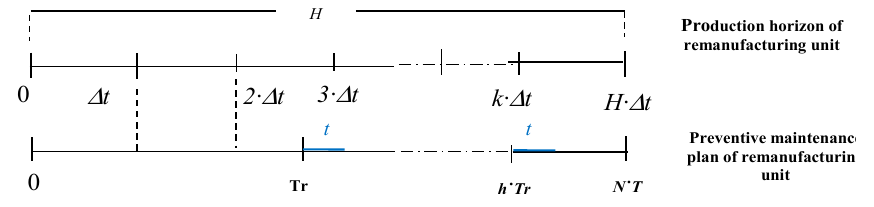
Figure 2. Production and preventive maintenance horizon.